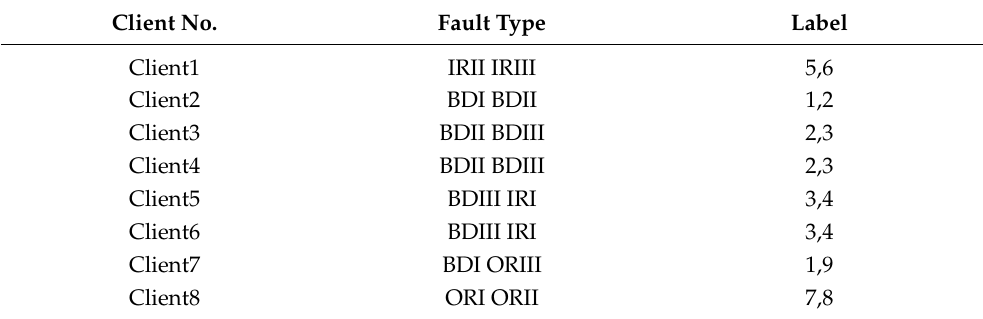
Table 3. Distribution of client data.